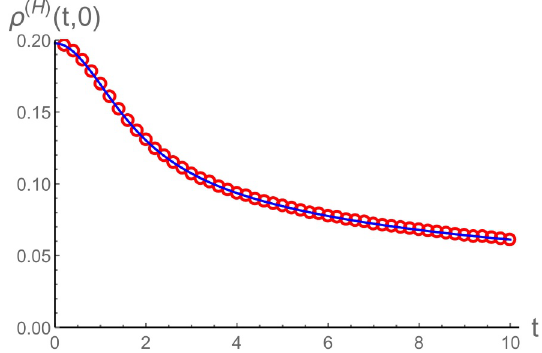
(cid:12) (open red circles) for (cid:12) (cid:15) =1